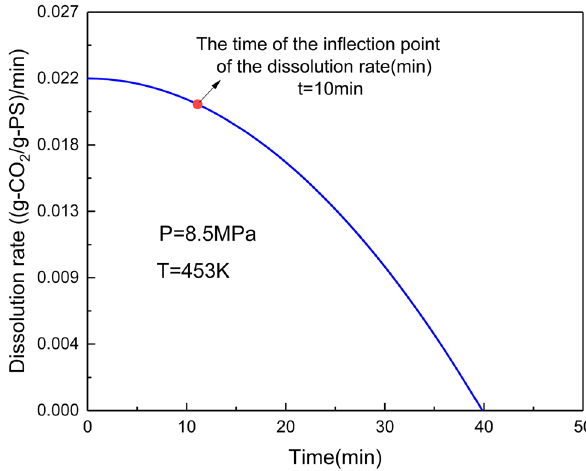
Figure 6: Dissolution velocity curves ( P = 8.5 MPa, T = 453 K ) under screw agitator and the time of the in fl ection point of the dissolu - tion